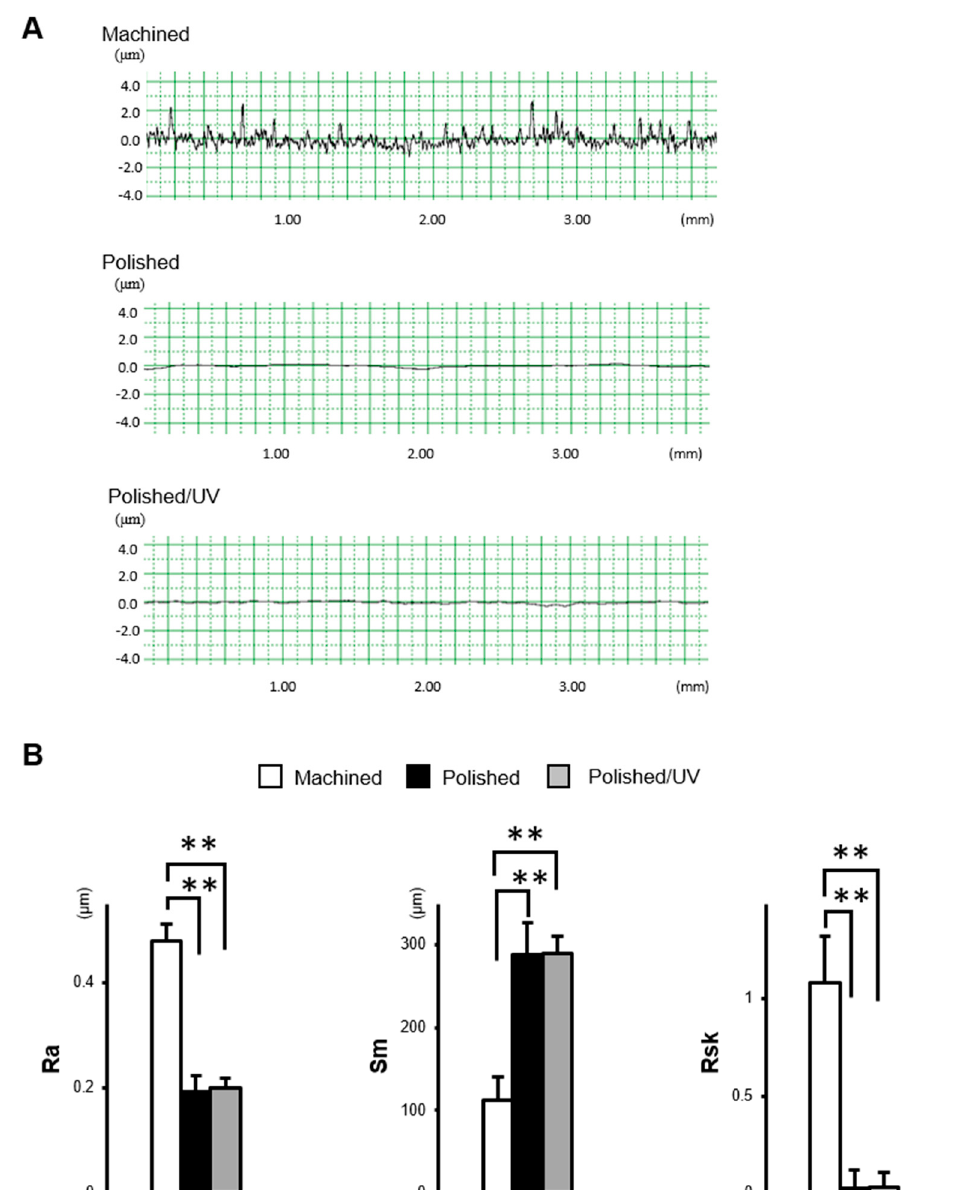
Figure 2. The surface characterization of titanium disks used in this study. ( A ) Two dimensional profile of titanium disks. ( B ) Quantitative topographical evaluation (histograms) of the titanium surfaces (** p < 0.01).